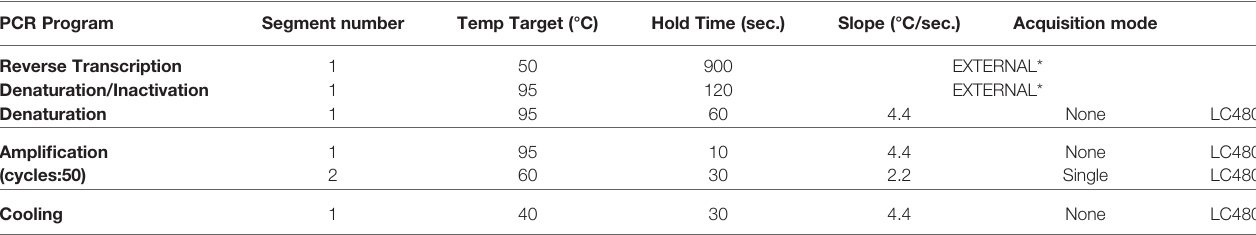
TABLE 2 | Cycling and temperature protocol for SARS-CoV-2 E-gene